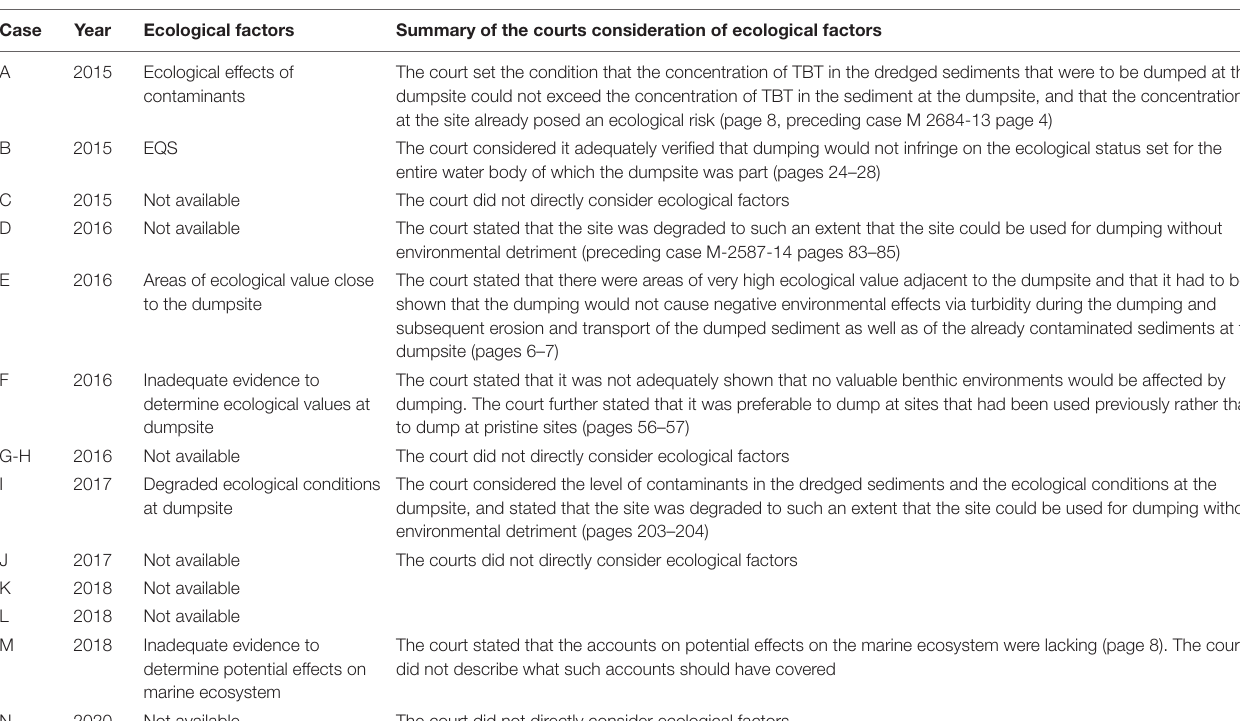
TABLE 5 | Ecological factors considered by the courts when evaluating if exemption could be granted without environmental detriment, followed by summaries of the courts’ reasoning considering ecological